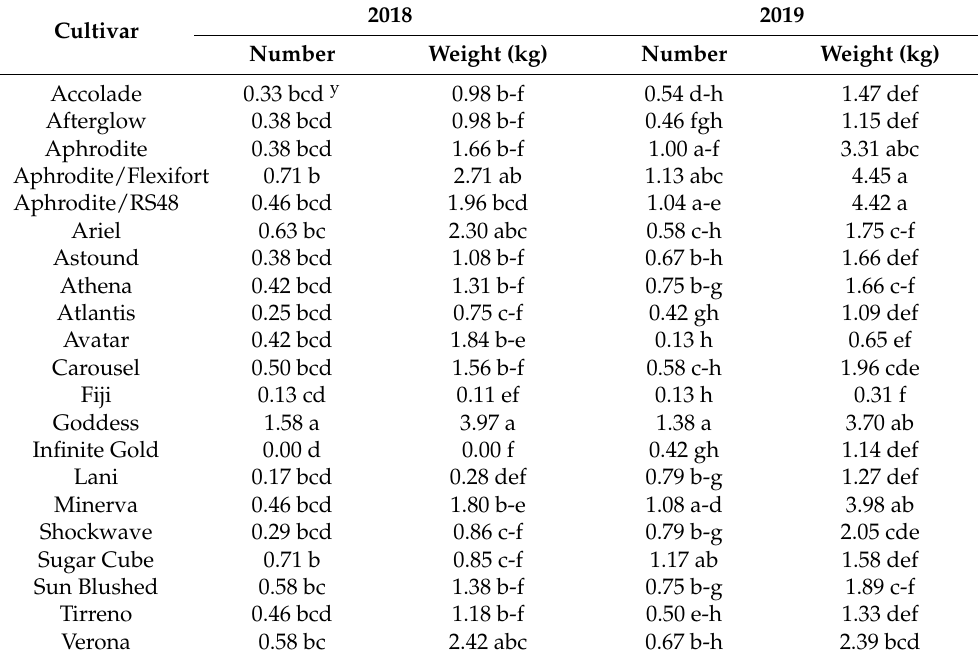
Table 8. Mean unmarketable number z and weight per plant of 20 muskmelon cultivars and two grafted entries evaluated in Southeastern Pennsylvania in 2018 and